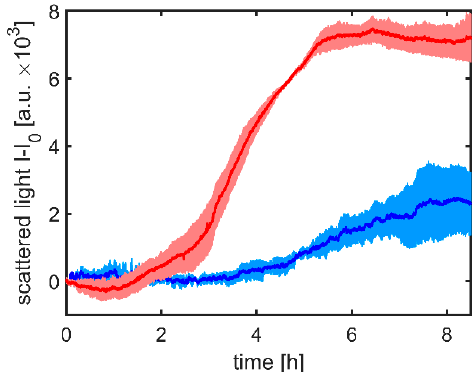
Figure 11. Cultivation of E. coli BL 21 in the GB-MBR mixed out of resonance (210 Hz, blue line) in comparison with resonant conditions (170 Hz, red line). As shown by SL, cells do grow marginally out of resonance. However, by adjusting to the resonance frequency, cell growth is substantially increased. The depicted curves are mean values of triplicates ( 𝑛 = 3 ).